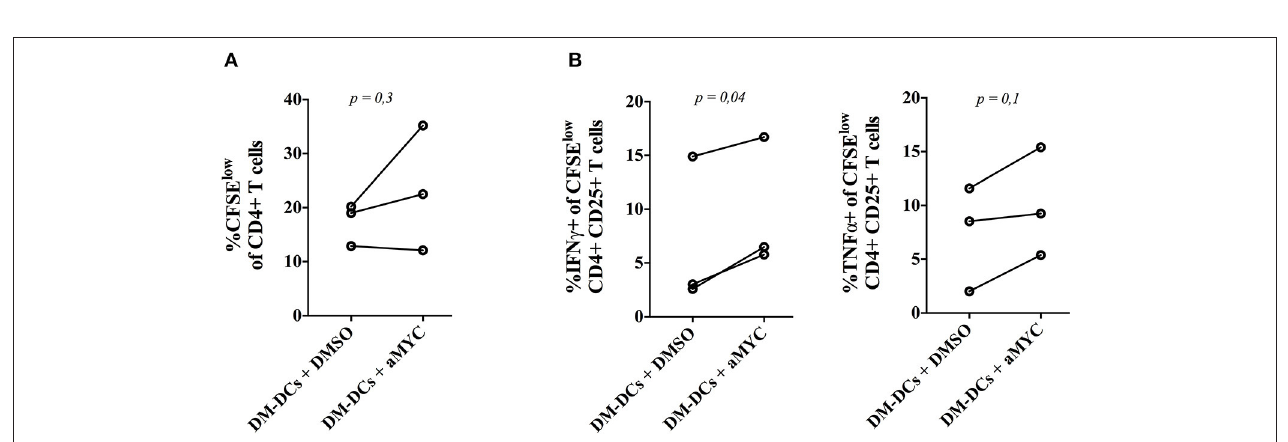
FIGURE 4 | MYC blockade impairs Dex-modulated and MPLA-activated dendritic cells (DM-DCs) regulatory function. Functional regulatory capacity of DM-DCs was assessed by co-culturing DCs, differentiated with or without the MYC inhibitor 10058-F4, with allogeneic CD4 + T cells for 6 days. After that, T cell proliferation and cytokine expression was determined by flow cytometry. (A) Percentage of CFSE low CD4 + T cells. (B) Percentage of IFN γ and TNF α producing T cells inside the proliferative CFSE low CD4 + CD25 + population. n = 3. DM-DCs, Dex-modulated MPLA-activated DCs + ; M-DCs, MPLA-matured